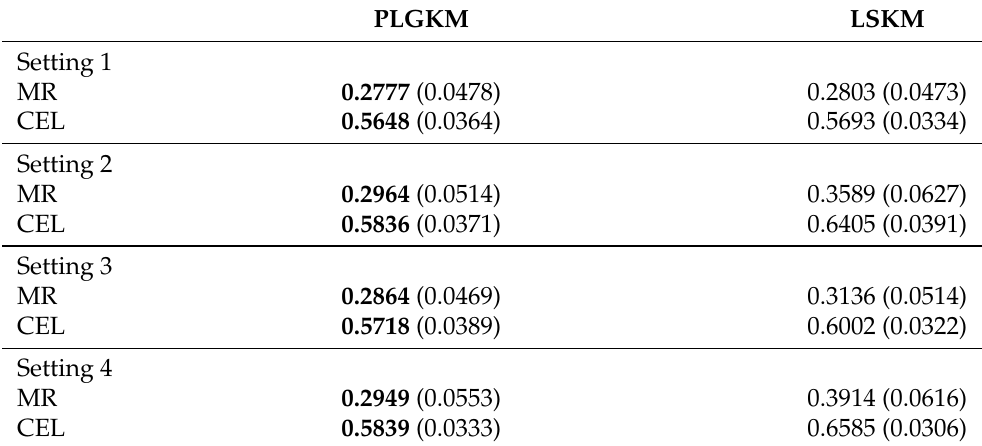
Table 1. MR and CEL of PLGKM and LSKM with standard deviations in parentheses. PLGKM